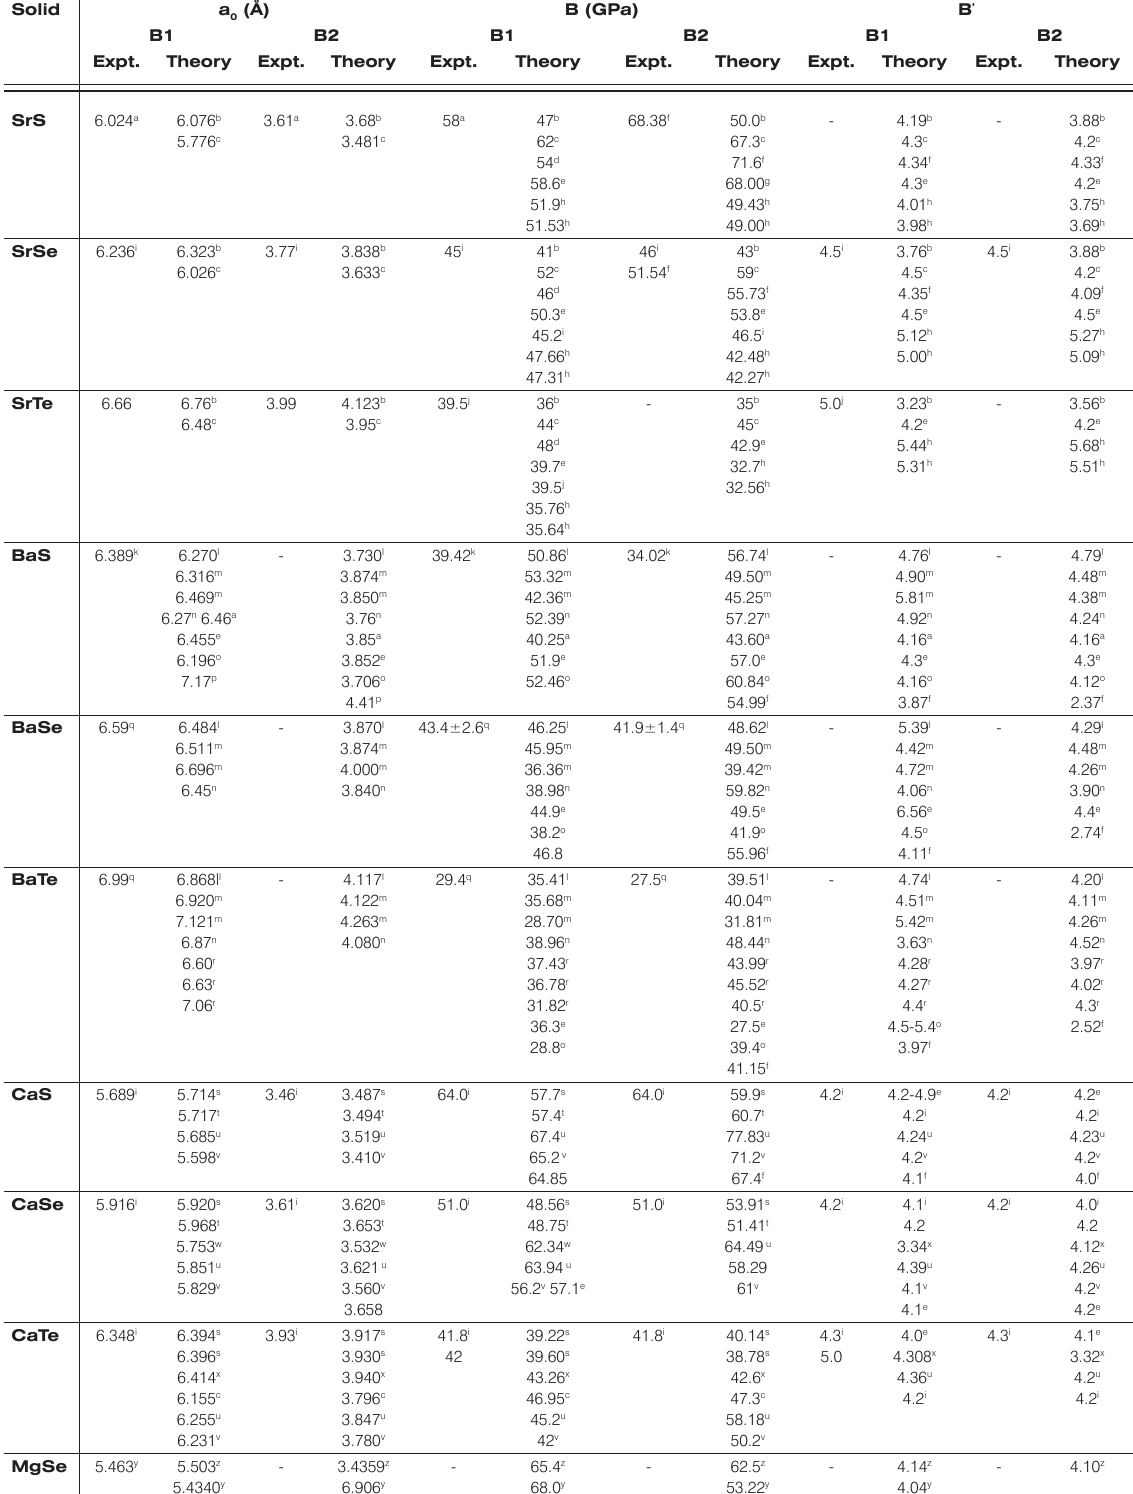
Table 1. Lattice constants a (Å), bulk modulus B (GPa) and pressure derivative of bulk modulus B’ of B1 and B2 phases for present 0 chalcogenides. Solid a (Å) B (GPa) B ’ 0 B1 B2 B1 B2 B1 B2 Expt. Theory Expt. Theory Expt. Theory Expt. Theory Expt. Theory Expt. Theory